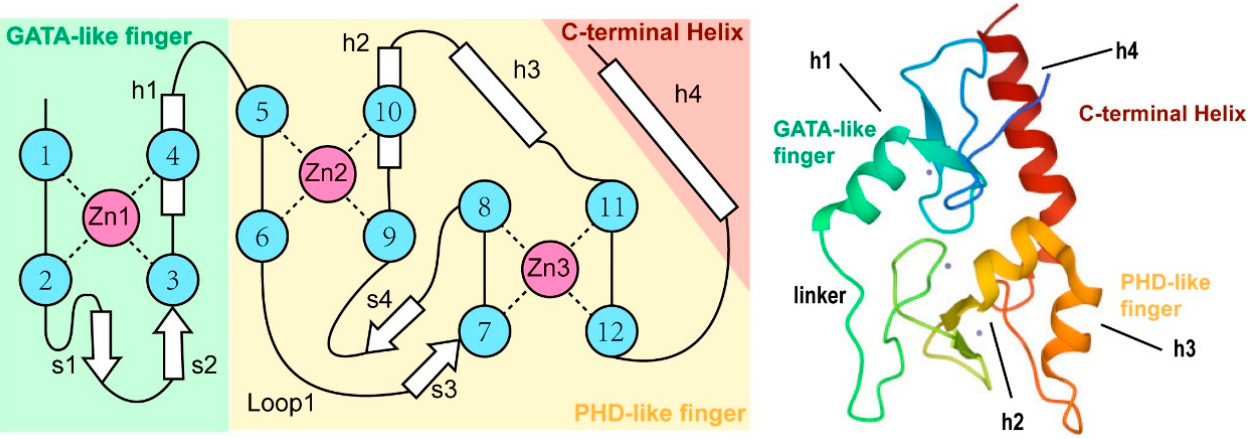
Figure 1. Schematic showing the zinc-binding topology and secondary structure elements of the ADD domain. Β -Strands are labeled s1–s4 and helices are labeled h1–h4. Ribbon representation of the NMR structure of the ADD domain of ATRX.